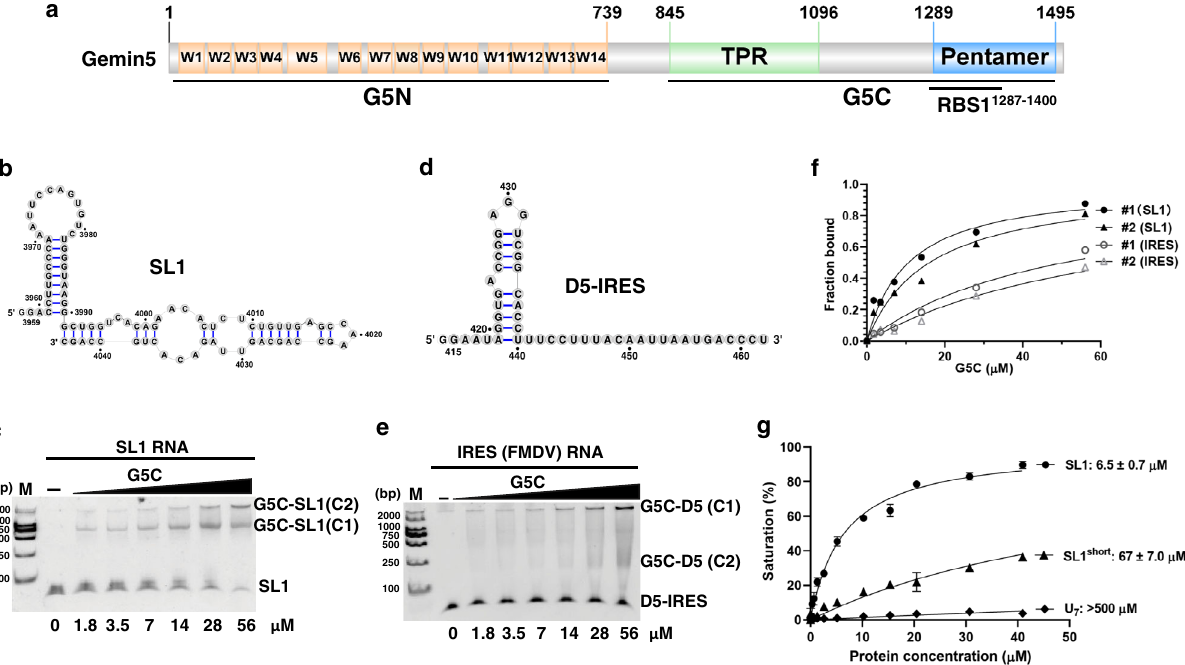
Fig.1|Puri fi edG5C(Gemin5 841 – 1508 )bindstoSL1mRNAandtheIRESregionofFMDVviralRNA.a DomainarchitectureofhumanGemin5,withtheWD40repeats,TPR domain, and C-terminal pentamer region shown in orange, green, and blue, respectively. The RBS1 region within G5C (aa 1287 – 1400) is annotated. b The sequence and predictedstructureoftheSL1regionderivedfromGemin5mRNA. c EMSAbindingassaybetweenpuri fi edG5CandSL1RNA.Theexperimentwasrepeatedindependently twice with similar results. d The sequence and predicted structure of the IRES D5 region (D5-IRES) derived from FMDV viral RNA. e EMSA binding assay between puri fi ed G5CandD5-IRES.Theexperimentwasrepeatedindependentlytwicewithsimilarresults. f BindingcurvesofduplicateEMSAforG5CbindingtoSL1RNAandD5-IRES,with the X - and Y -axes indicating the G5C concentration and fraction bound, respectively. g FP binding assay for G5C binding to SL1, SL1 short , and poly-U (U 7 ) RNAs with the indicated K D values.Datarepresentedasmean±SD( n = 2perconcentrationandtwoindividualexperiments).InFig.1cand1e,C1andC2representlowerandupperband,